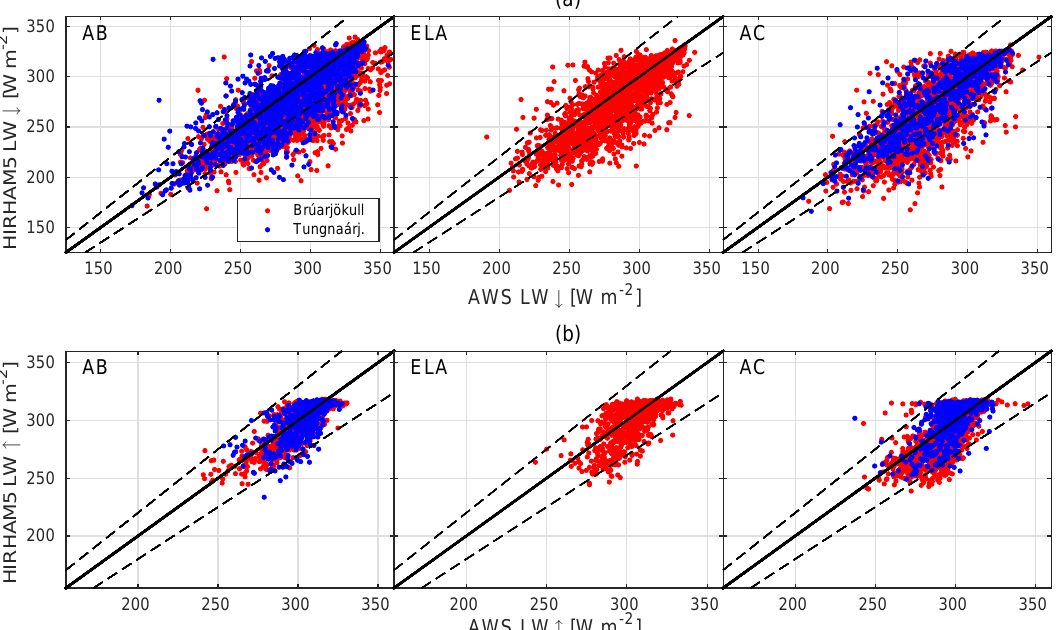
Figure 3. Scatter plots of the measured longwave radiation components, LW ↓ and LW ↑ , by stations on Brúarjökull (red) and Tungnaárjökull (blue) versus the LW radiation components simulated by HIRHAM5 at the same locations. The dashed line corresponds to ± 10%, i.e. the manufacturer-reported uncertainty of the AWS